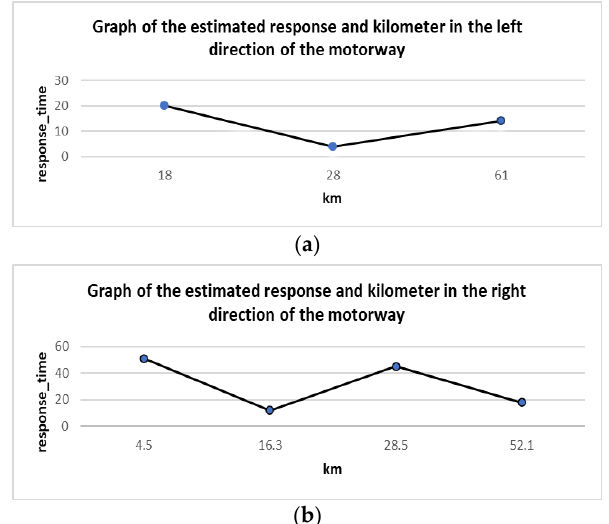
Figure 9. Output Graph of the estimated response time per field personnel cluster in ( a ) the left direction towards Igoumenitsa and ( b ) the right direction towards Ioannina.